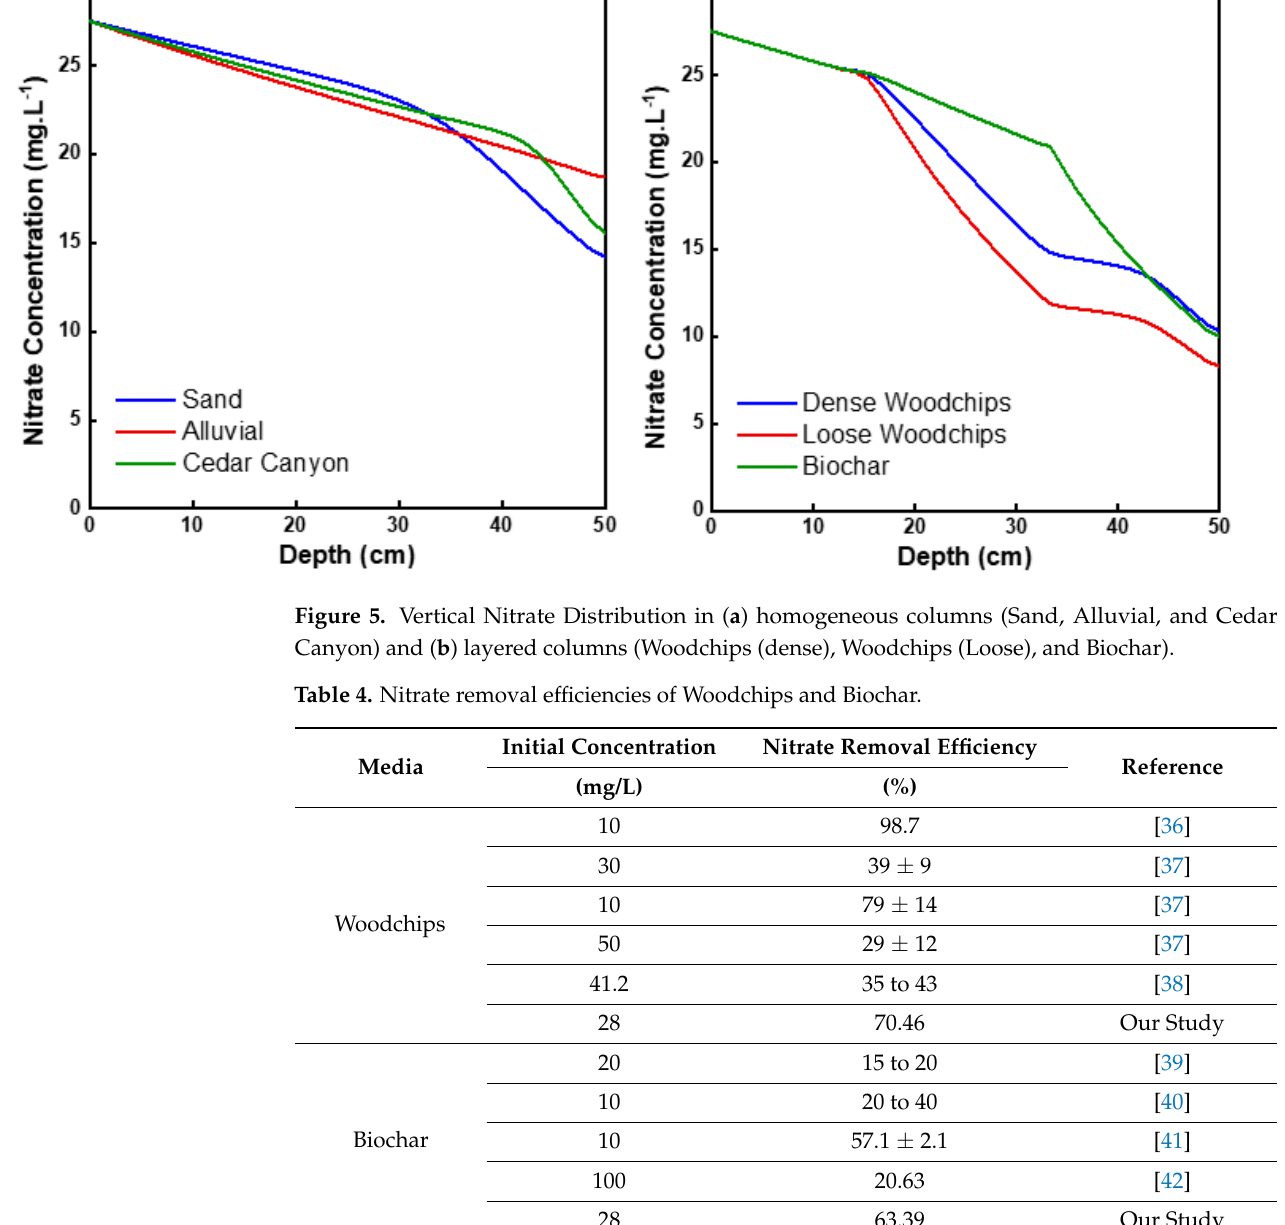
for each of the calibrated columns is shown in Figure 6a–f.